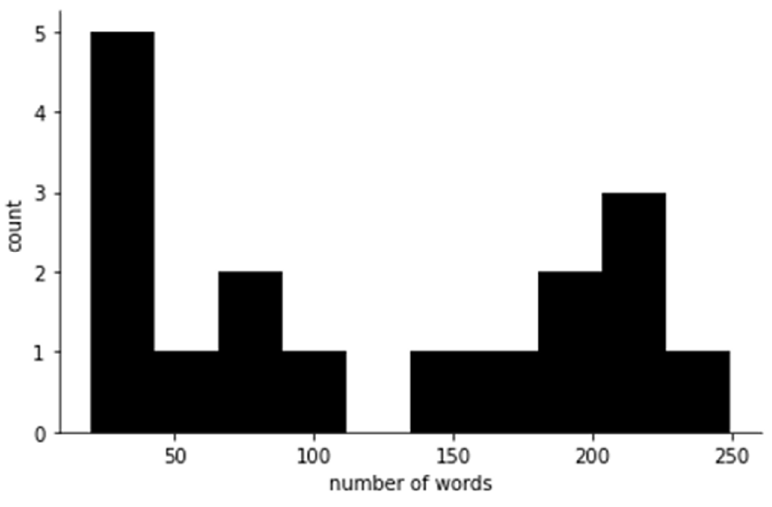
Figure 1. Histogram of proposal word counts.